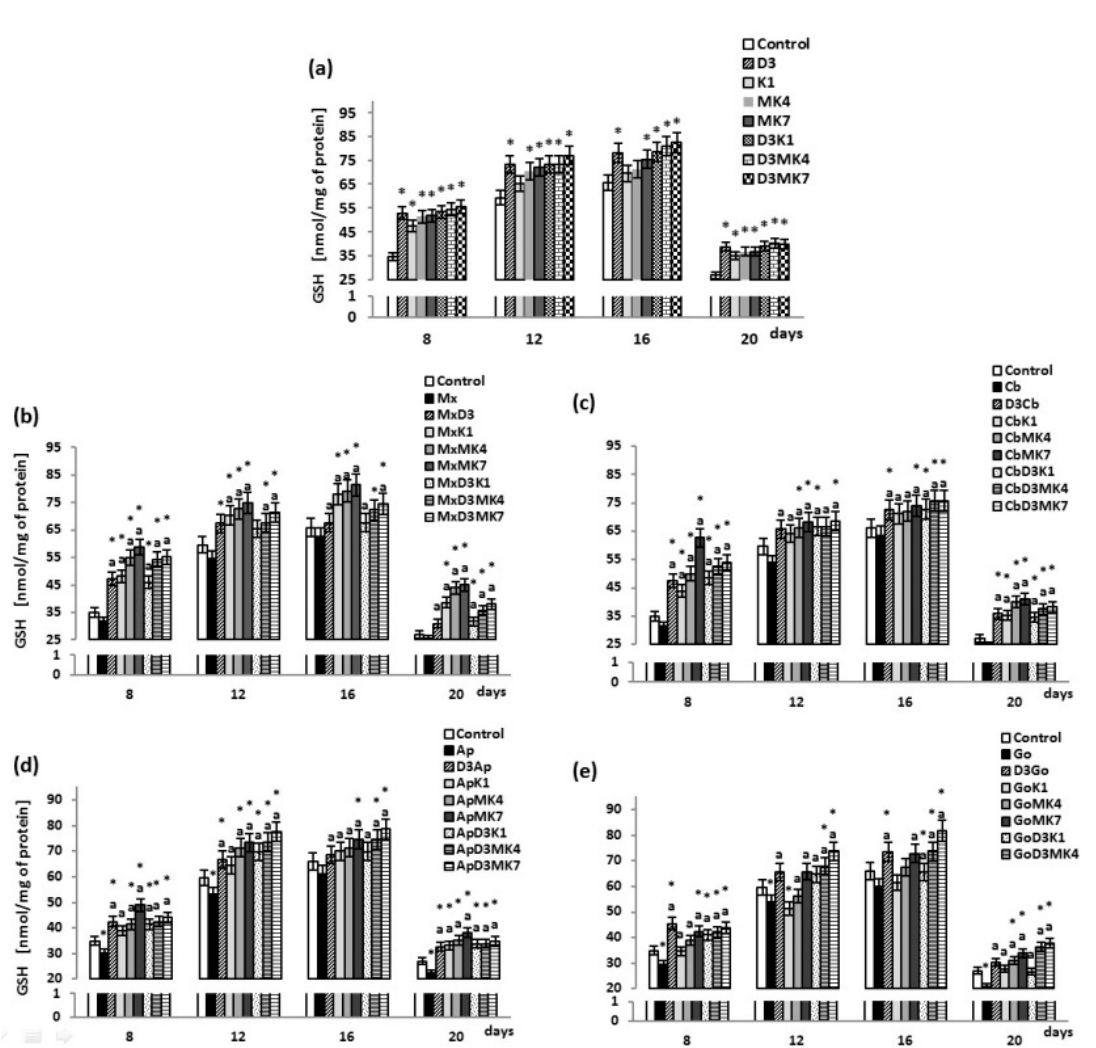
Figure 2. Glutathione (GSH) level in osteoblasts after incubation with hydroxyapatites and treated with vitamins D3, K1, MK4, and MK7 after 8, 12, 16, and 20 days. The results are expressed as the nmol/mg of protein and are shown as the mean ± SD ( n = 5). The values for the control cells and the treated cells were significantly different according to unpaired Student’s t -test. * Statistically significant differences versus control, p < 0.05; ( a ) statistically significant differences versus group hydroxyapatites (Mx (Maxgraft), Cb (Cerabone), Ap (Apatos), Go (Gen-Os), respectively for graphs ( b – e )); p < 0.05.